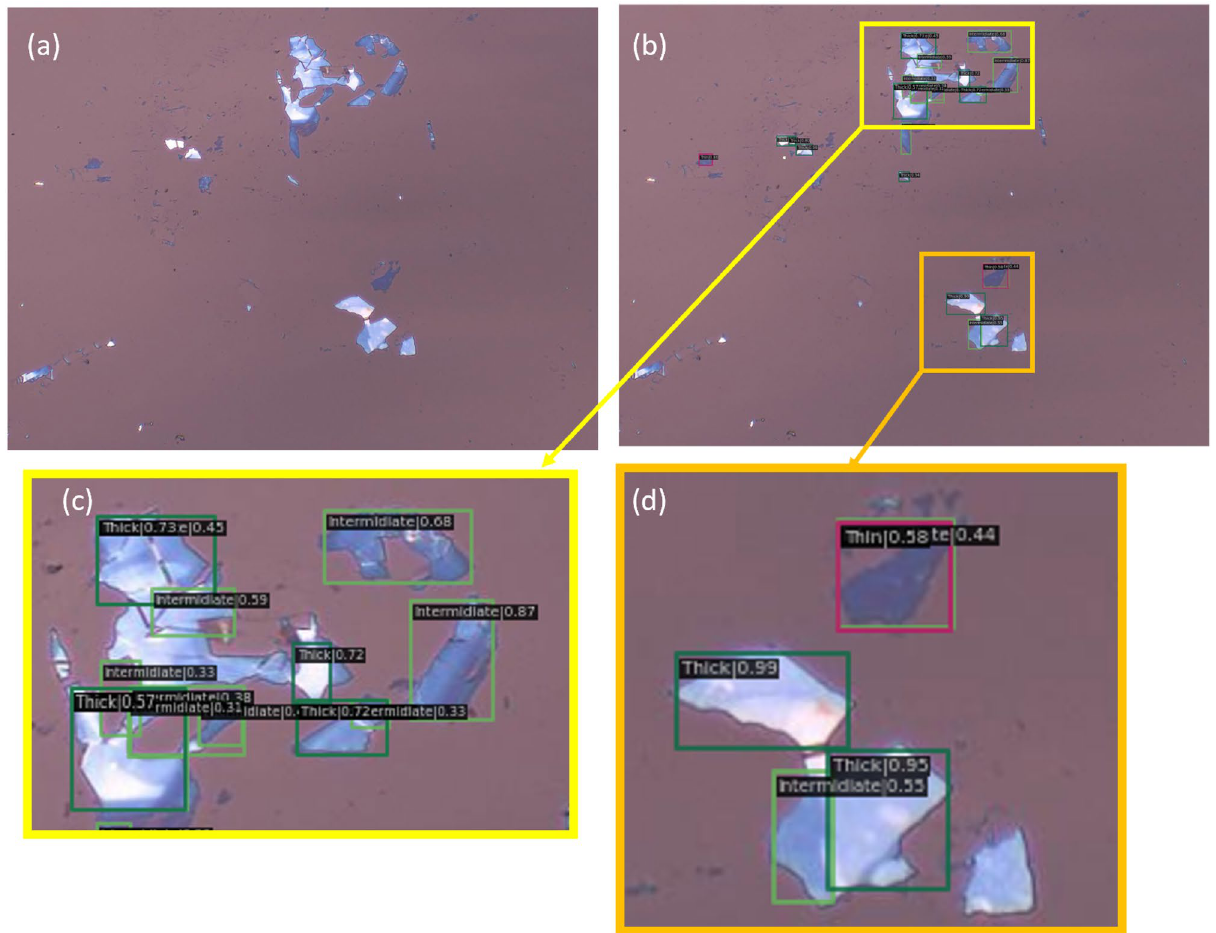
Figure 2. Results obtained from using the proposed algorithm on one image from our dataset; Part ( a ) shows the raw image, part ( b ) shows the labels generated by the algorithm, and parts ( c ) and ( d ) are zoomed-in regions showing the flake type and confidence score reported by the algorithm. We manually identified 19 flakes in the image, and the algorithm correctly classified 14 of